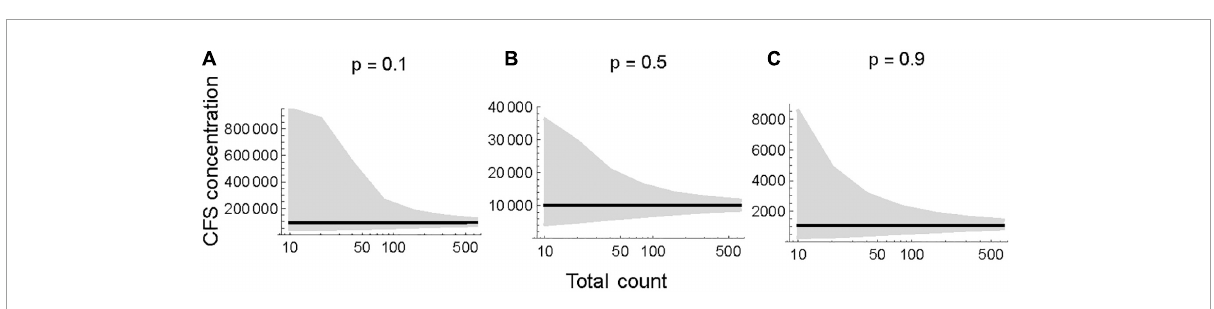
FIGURE3 Maximum likelihood estimate (black) and 95% CI (gray shading) of spore concentration as a function of total count. Tracers are (A) rare 0.1, (B) equally frequent 0.5, and (C) abundant 0.9. Note the different Y axis